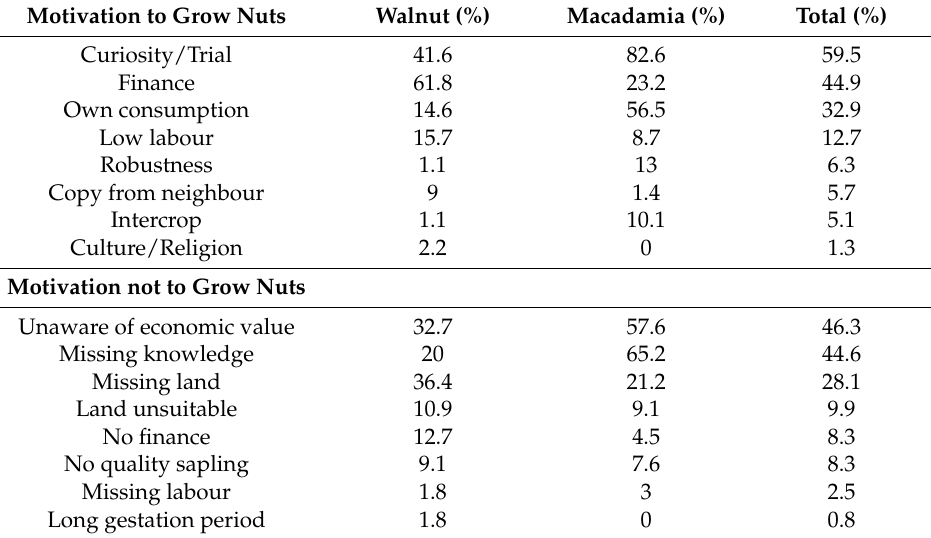
Table 3. Motivation to grow nuts or not to grow